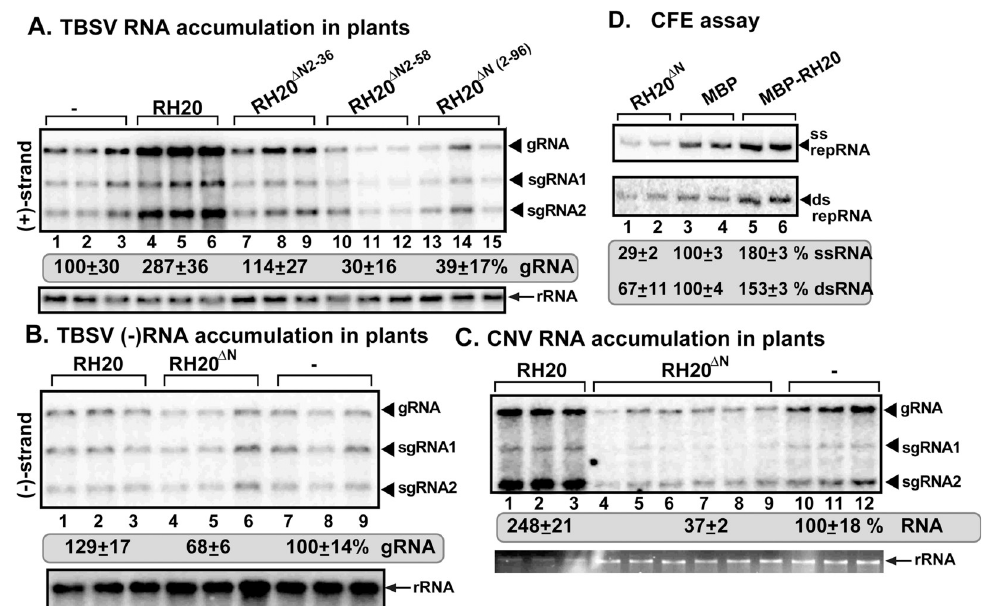
Fig 6. Effects of expression of truncation mutants of the pro-viral RH20 DEAD-box helicase on tombusvirus genomic (g)RNA replication in N . benthamiana plants. (A) N . benthamiana plants transiently expressing the N- terminal truncation derivatives of RH20 helicase were inoculated with TBSV. Top panel: Northern blot analyses of tombusvirus gRNA using a 3’ end specific probe shows the accumulation level of gRNA and subgenomic RNAs in plants expressing RH20 helicase and its derivatives when compared with control plants. Bottom panel: Northern blot shows 18S ribosomal RNA as a loading control. (B) Northern blot analyses of TBSV gRNA using a 3’ end specific probe for (-)RNA detection. TBSV (-)RNA levels were normalized to 18S rRNA levels. In comparison of full-length RH20 and the control samples, the statistical test shows P < .0001. In comparison of RH20 Δ N and the control samples, the statistical test shows P = .0485. (C) N . benthamiana plants expressing RH20 Δ N or RH20 helicases were inoculated with CNV. See further details in panel A. (D) An in vitro replicase reconstitution assay shows the inhibitory effect of RH20 Δ N helicase on TBSV repRNA accumulation. The purified recombinant tombusvirus p33 and p92 pol replication proteins from E . coli were added in combination with the template (+)repRNA to program the yeast-based CFE assay. The affinity-purified recombinant MBP-RH20 Δ N (1.9 μ M), MBP-RH20 (1.9 μ M each) or MBP (1.9 μ M), as a control, were added to the reactions. Non- denaturing PAGE shows the accumulation of 32 P-labeled (+)repRNAs and the dsRNA replication intermediate products made by the reconstituted replicases. Each experiment was repeated three times. In comparison of MBP-RH20 Δ N and MBP control samples, the statistical test shows P = .038. In comparison of MBP-RH20 and MBP control samples, the statistical test shows P =